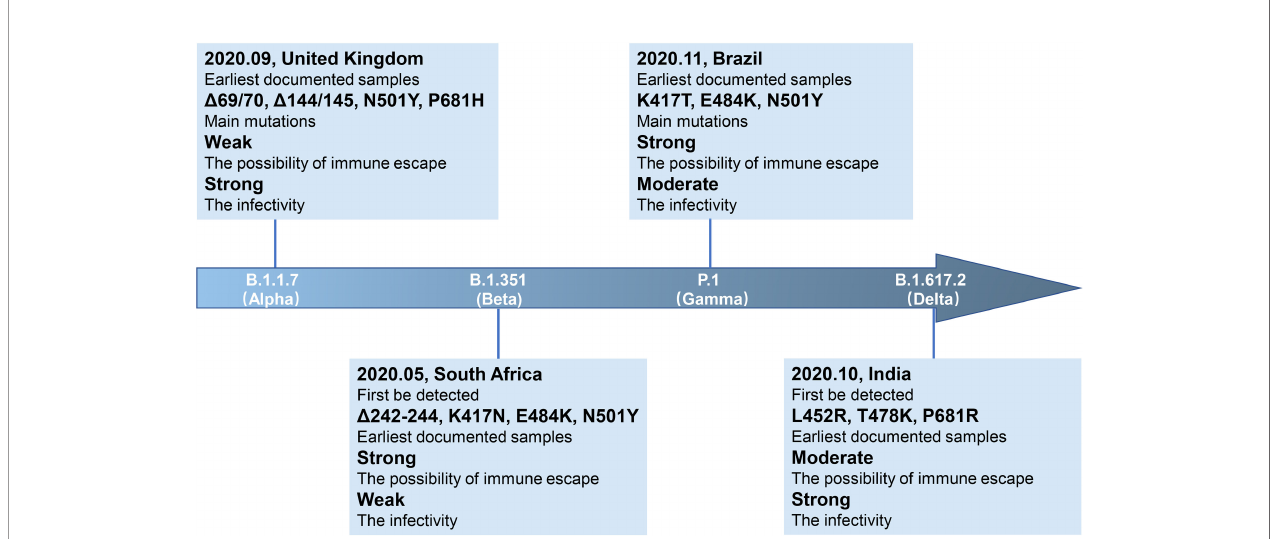
FIGURE 1 | Brief information of four VOC variants. Four VOC variants (B.1.1.7, B.1.351, P.1, and B.1.617.2) are marked in the arrow according to the date of designation, and their related brief information (e.g., the time and location of earliest documented samples, infectivity, main mutations, immune escape ability) are displayed in the corresponding location.